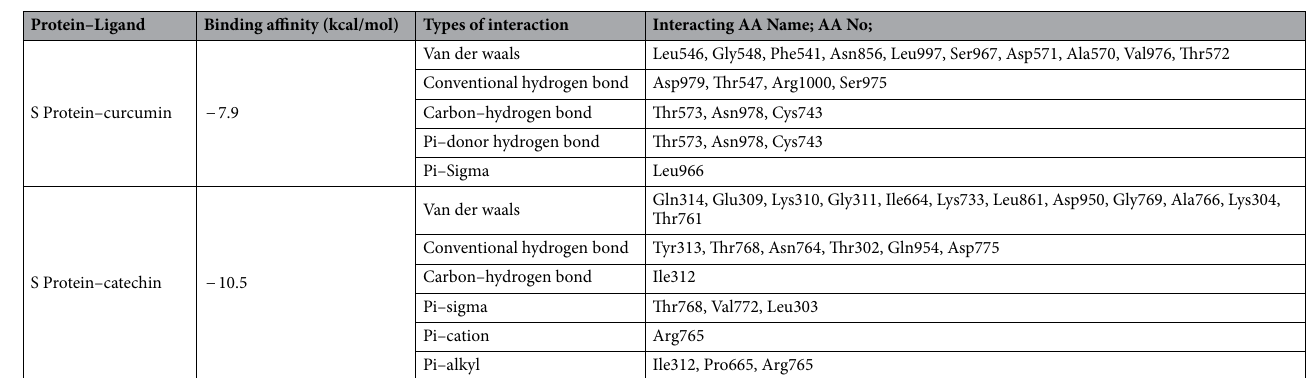
Table 2. The binding energy, types of interaction and amino acids involved in the interaction of S protein of SARS-CoV2 with curcumin and